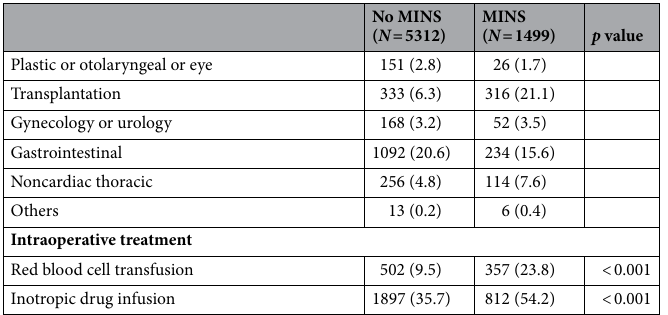
Table 1. Baseline characteristics of patients according to myocardial injury after non-cardiac surgery (MINS). Data are presented as n (%), mean (± standard deviation). ESC, European Society of Cardiology; ESA, European Society of Anaesthesiology.